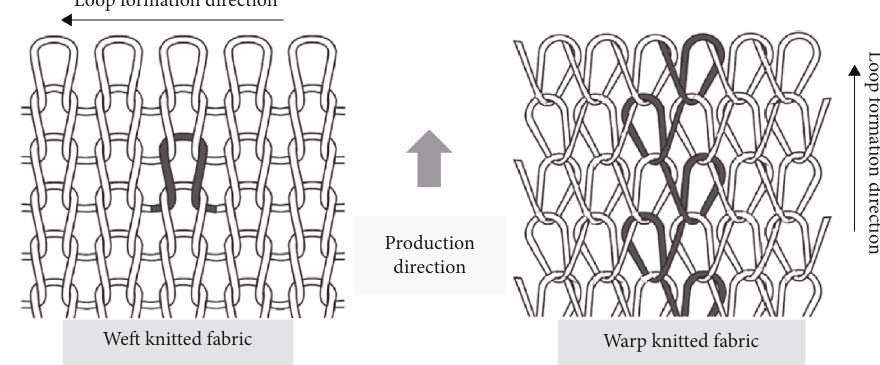
Figure 4: Schematic diagram for weft-knitted structures [28].